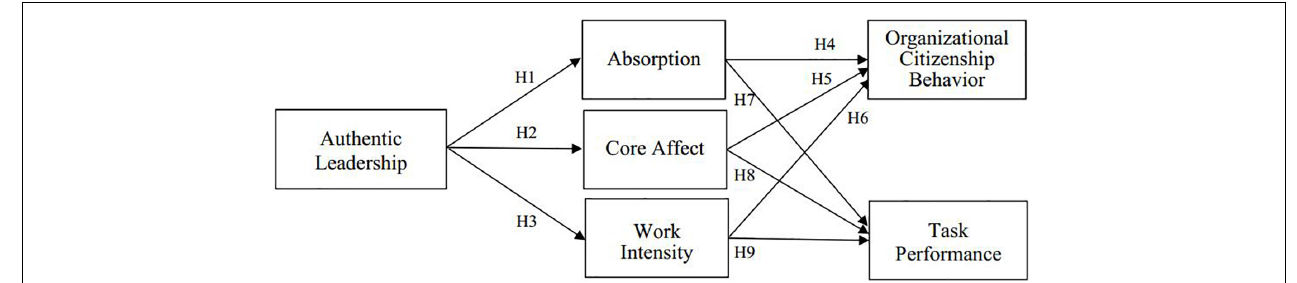
FIGURE 1 | Research model of this